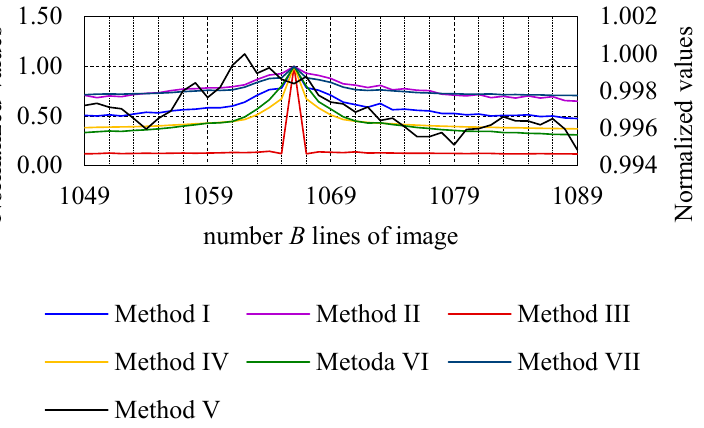
Figure 11. Normalized values (in relation to the maximum value) of the variability of measures as a function of the number of image lines, supporting the determination of the correct number of lines of the image reproduced for the source image in the form of a picture from Figure 7a—HDMI graphic standard, computer monitor operating mode 1280 × 1024/60 Hz, frequency of the reveal emission signal f o = 1334 MHz, reception bandwidth BW = 50 MHz, correct number of lines B Corr = 1066 .